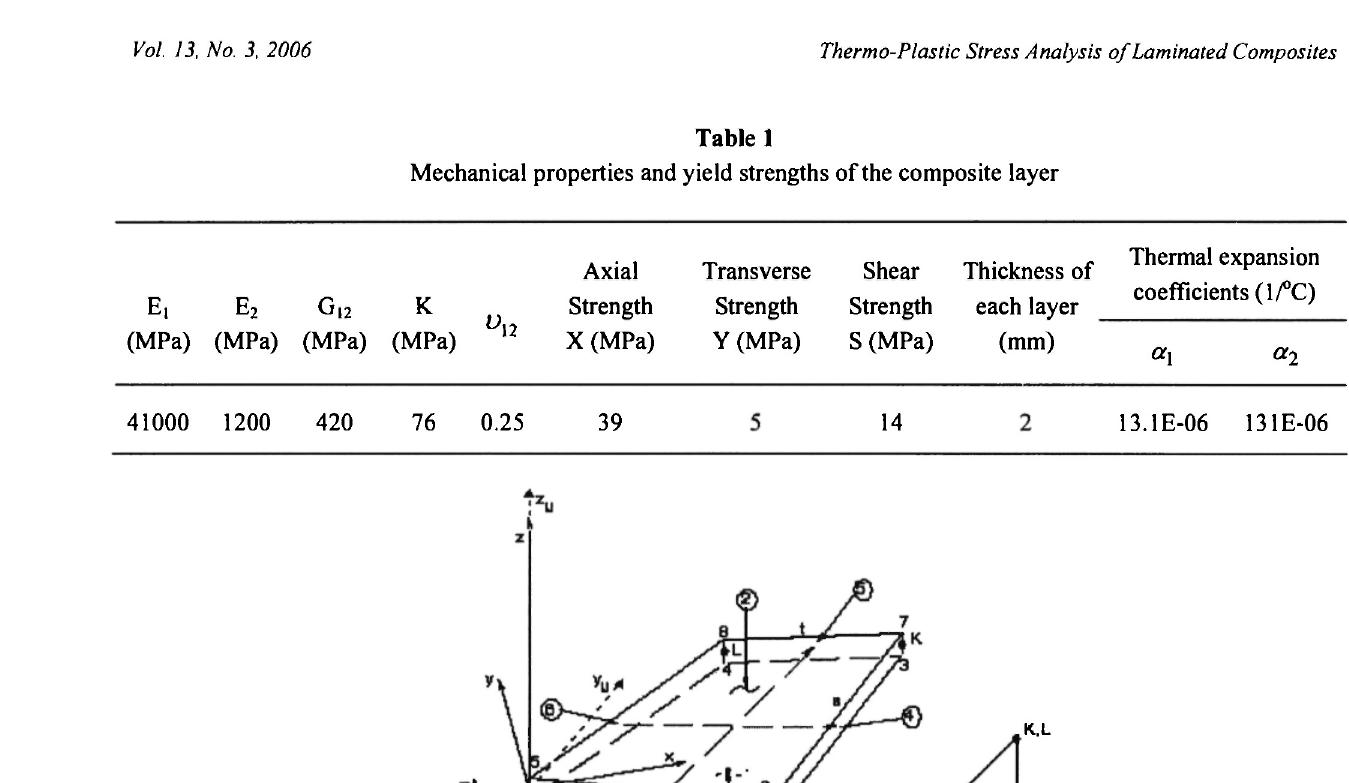
Fig. 2: The geometry, node locations, and the coordinate system for SHELL 181 element 719/